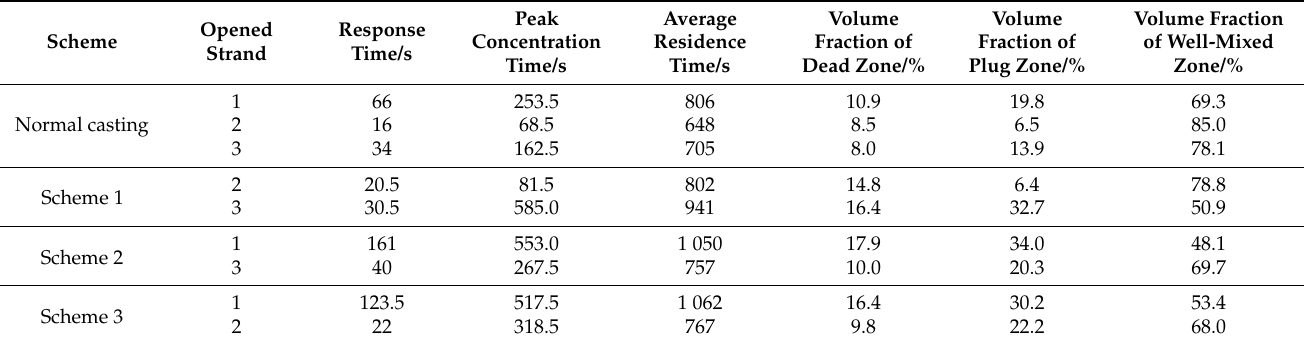
Table 4. Numerical result of RTD curves in tundish with each